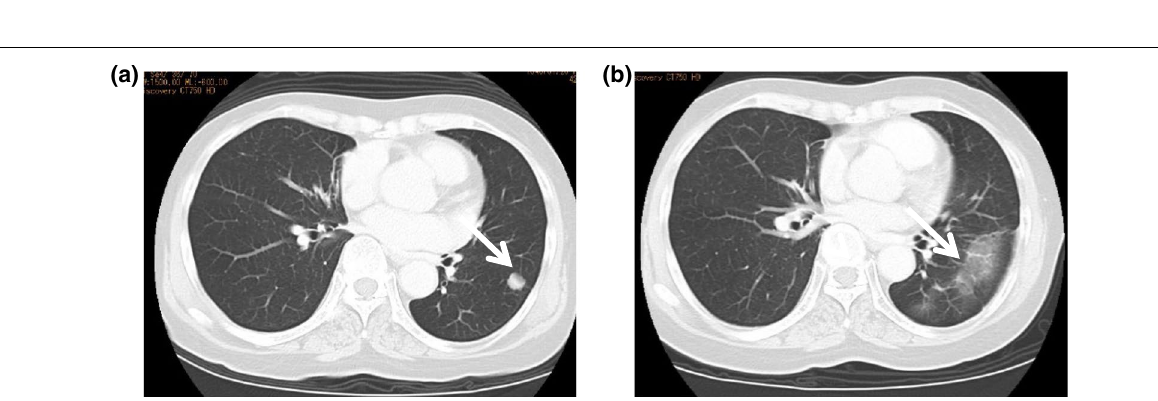
Fig. 6 a Chest CT scan showing the presence of lung metastases (white arrow). CT, computed tomography. b Chest CT scan showing the disappearance of lung metastases after radiotherapy (white arrow). CT computed